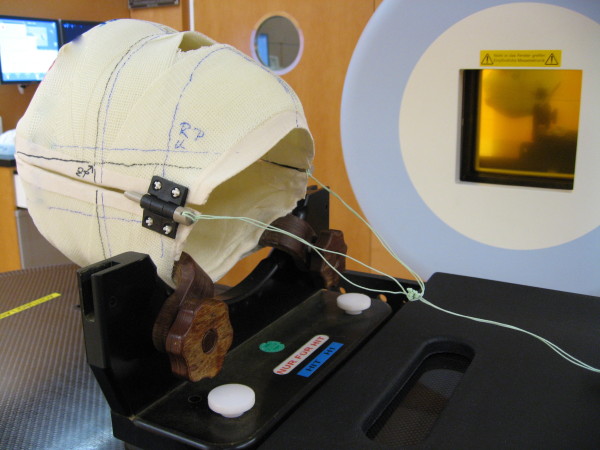
Scotchcast mask.